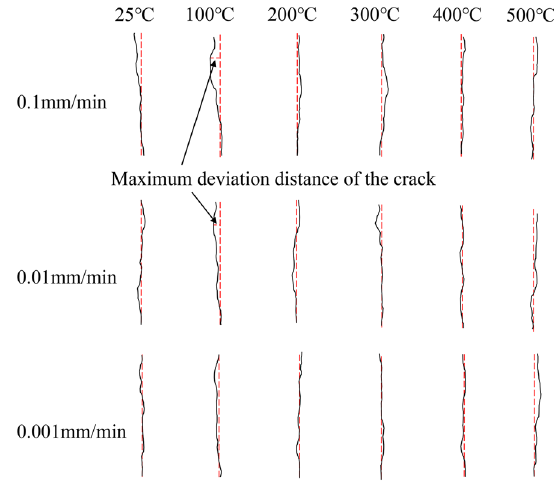
Fig. 8 Macro‑fracture traces